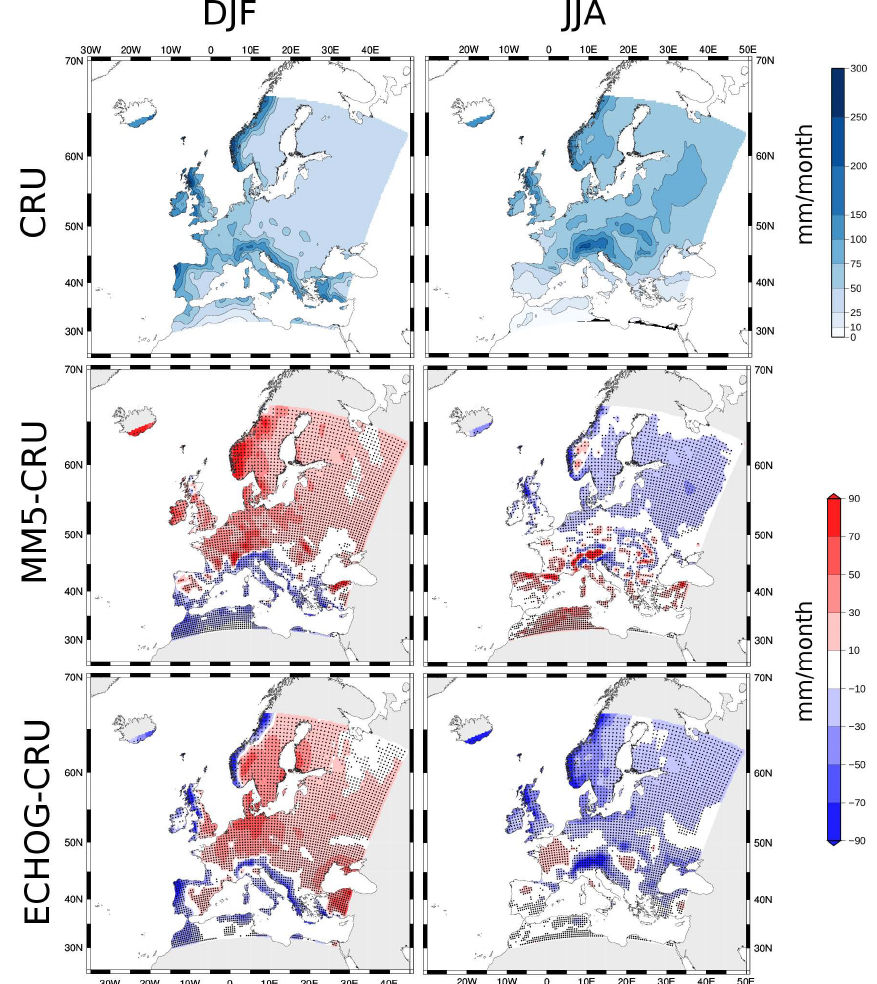
Fig. 4. Precipitation averaged (in mmmonth − 1 ) for the 1960–1990 period in winter (left panels) and summer (right panels) in CRU (top panels), and differences between MM5 driven by ECHO-G (middle panels) and ECHO-G alone (bottom panels) with respect to the former. To perform the calculations, all datasets are spatially interpolated onto the MM5 grid, and only non-ocean grid cells are considered. The significance of the differences is tested through a two-tailed t test at the 95% confidence level and it is indicated with small black circles in the